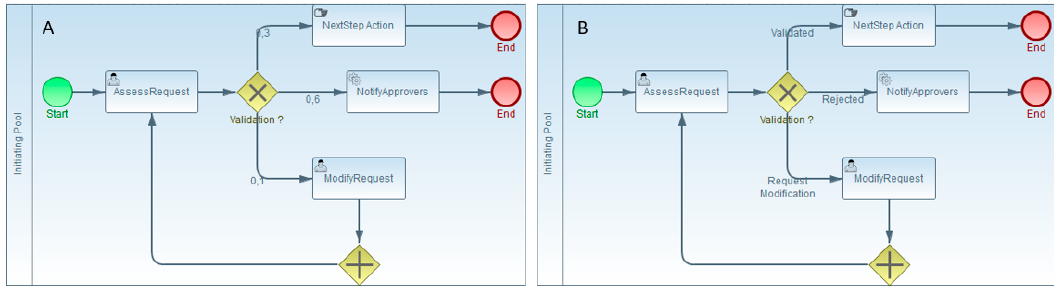
Figure 11. Path choice techniques.